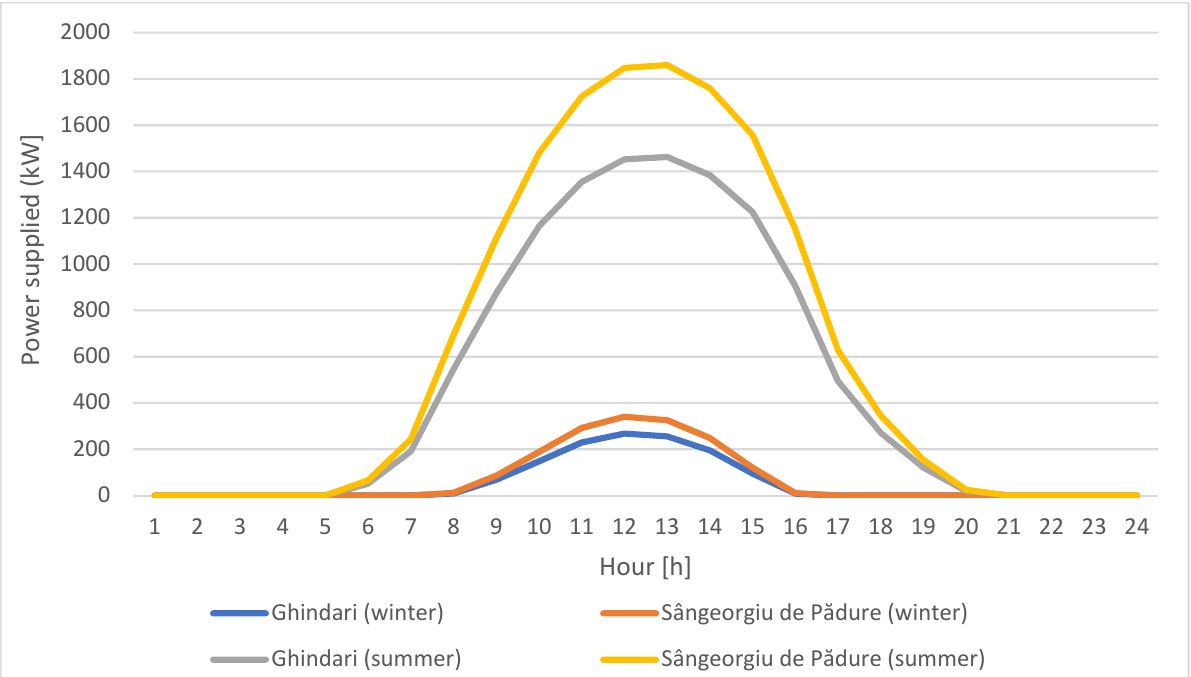
Figure 2. Power supplied by the PV power plants during summer and winter.